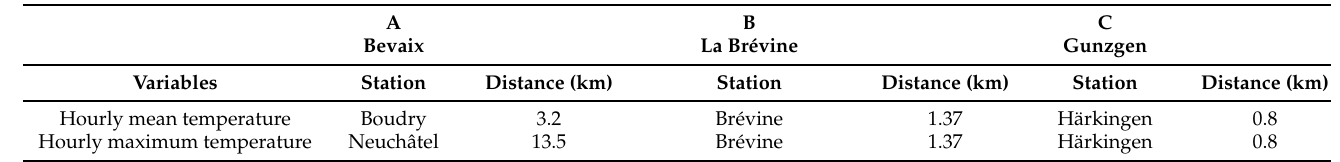
Table A2. Location and distance to study sites of the meteorological stations used in this